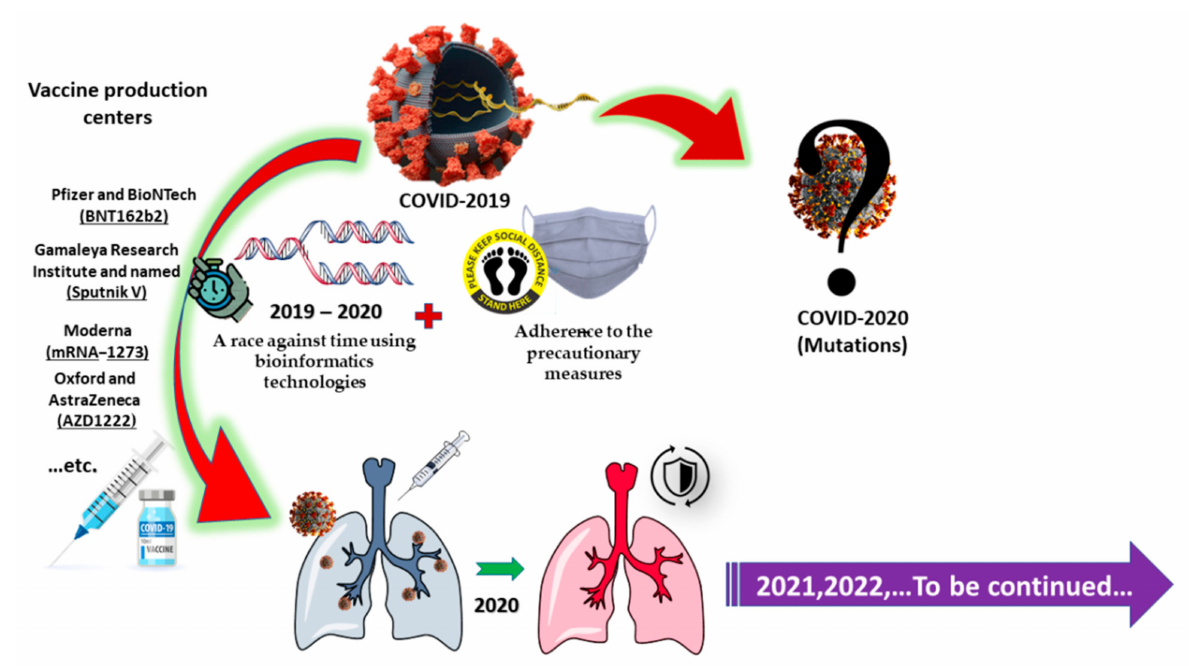
Figure 3. Impact of the COVID-19 pandemic on the vaccine production process and new